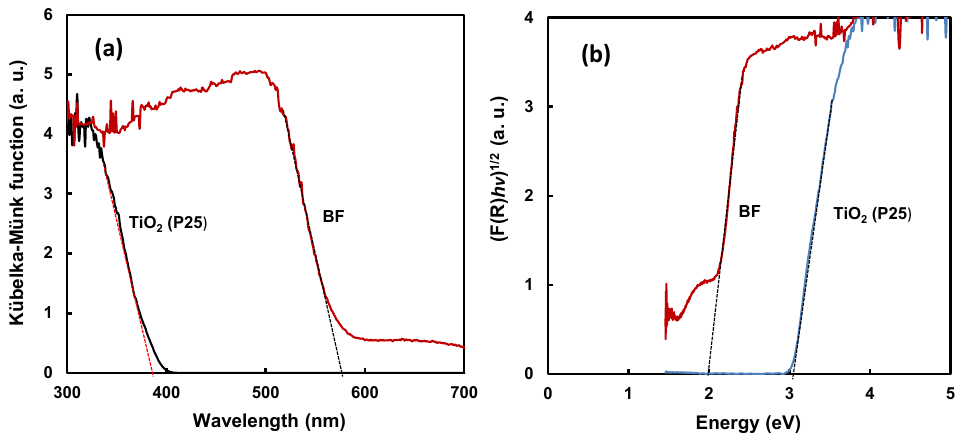
Figure 5. ( a ) Plot of the Kübelka–Münk function converted from UV-visible DRS and ( b ) relationship of (F(R) h ν ) 1/2 versus energy.